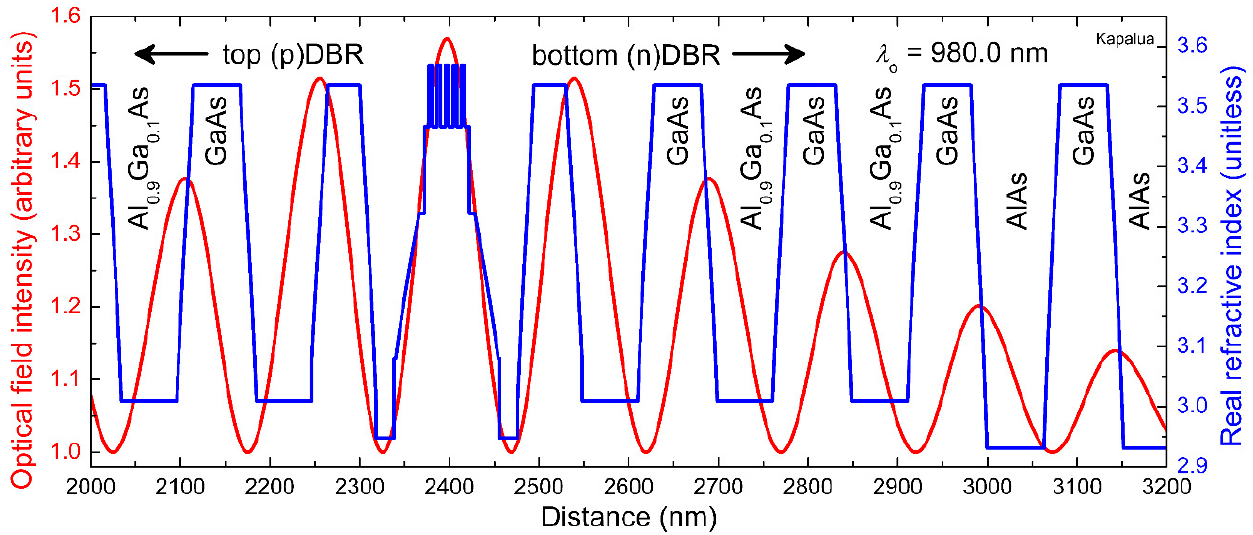
Figure 1. Simulated one-dimensional optical field intensity on resonance (red curve) and real refractive index (blue curve) along the epitaxial growth direction in and around the quantum well (QW) active region for the Kapalua 980 nm vertical cavity surface emitting laser (VCSEL) design.